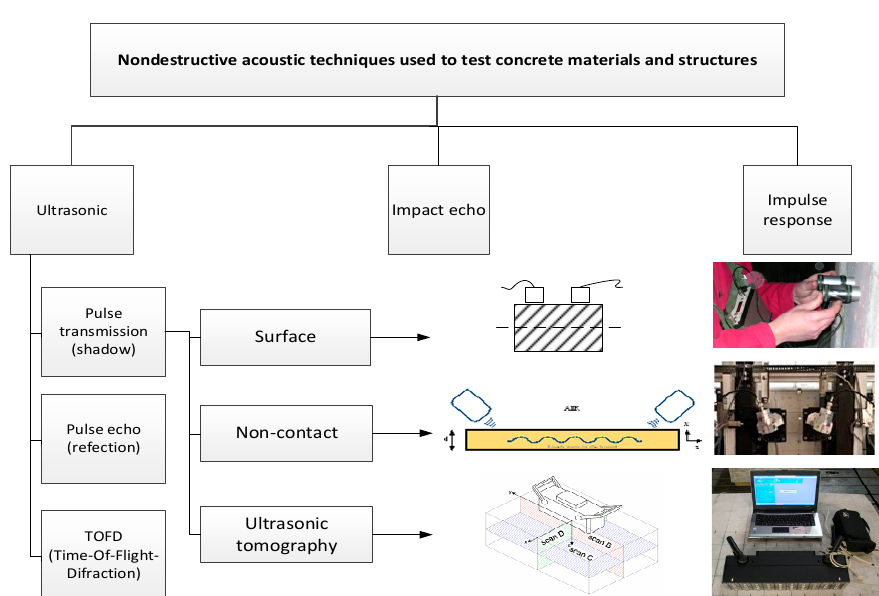
Figure 4. Classification of non-destructive acoustic methods suitable for testing concrete materials and structures [1,2].